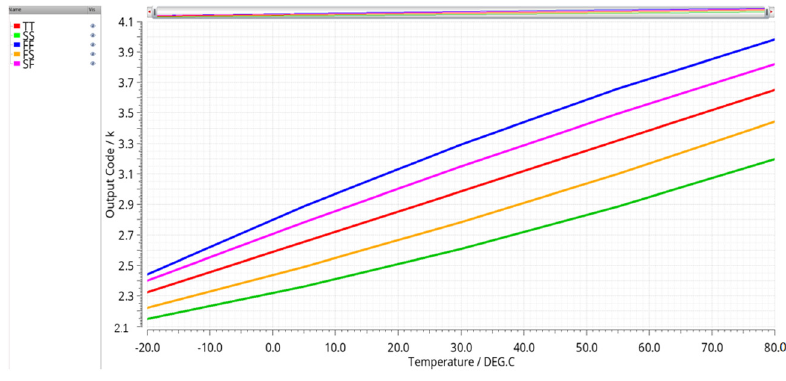
Figure 13. Post-simulation results of the temperature sensor outputs at five different corners.